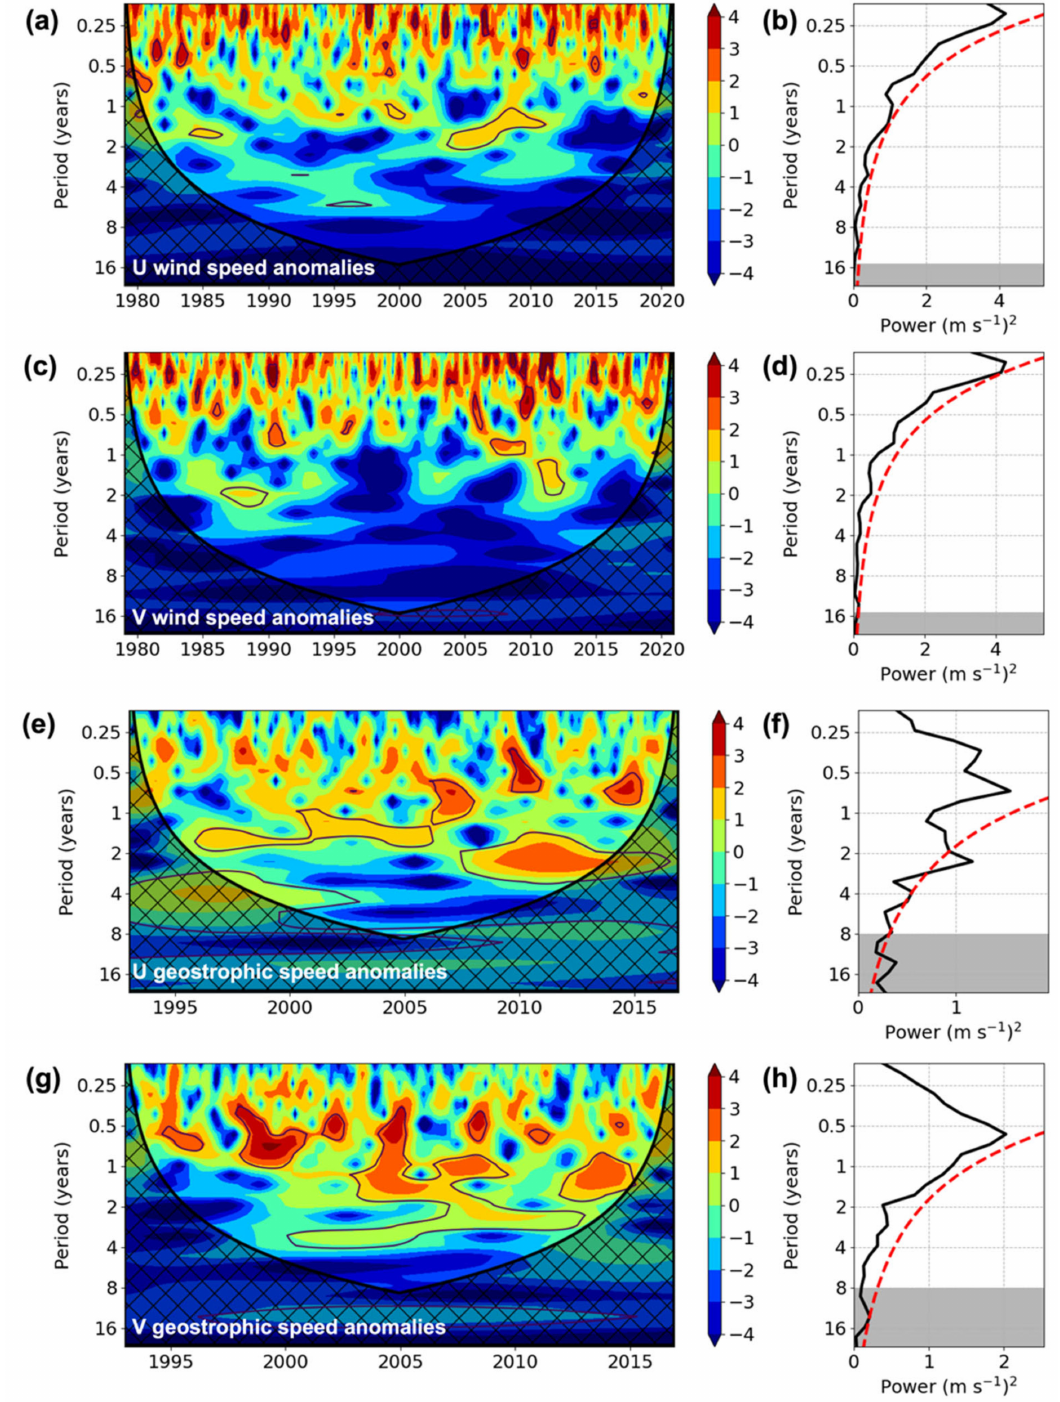
Figure 7. Wavelet power spectra of the standardized monthly anomalies of ( a , b ) Zonal (U) wind speed, ( c , d ) Meridional (V) wind speed, ( e , f ) Zonal (U) geostrophic current speed and ( g , h ) Meridional (V) geostrophic current speed. The 95% confidence level regions are highlighted in red and circled by a black contour. The cross-hatched regions are considered insignificant due to the effect of zero padding. The dashed red lines on the global wavelet spectra (on the right) represent the 95% confidence level, and the grey shaded regions are insignificant due to zero padding. Significant variability in R geos was observed at periods of 0.5–1.5 years and 3.7–5